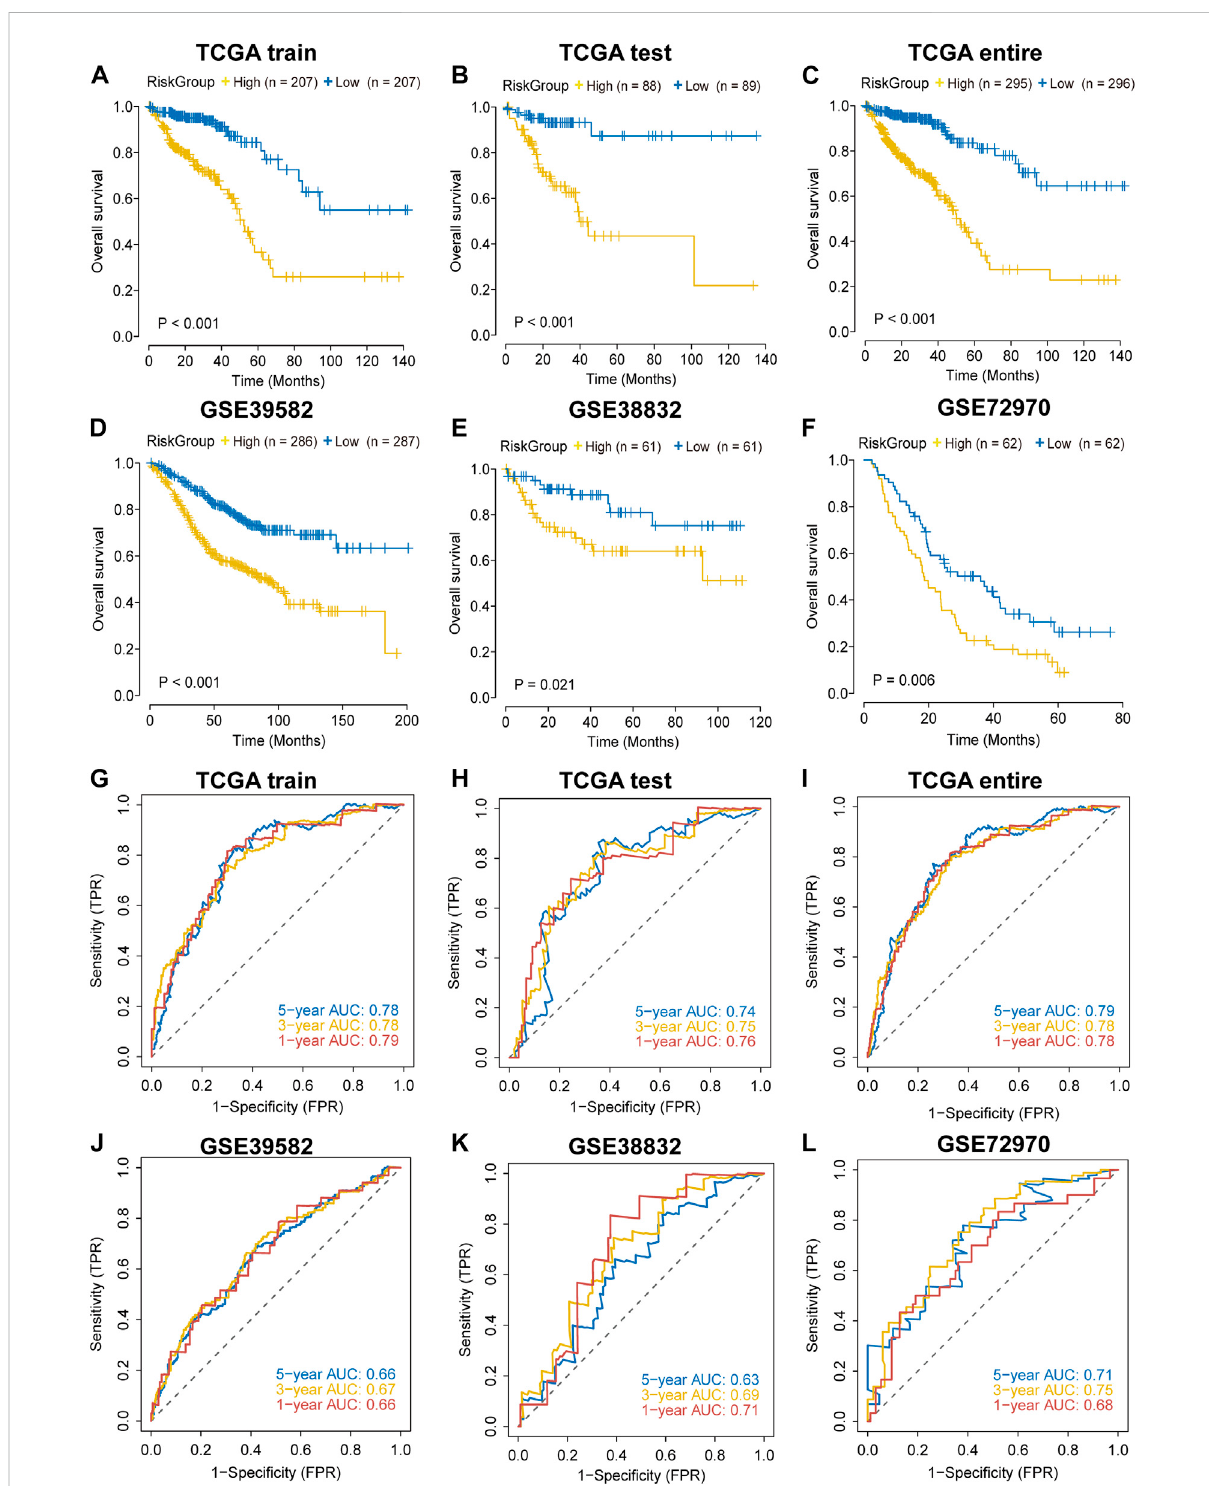
FIGURE 2 Validation of the performance of the IRLncSig for prognostic prediction (A – F) Survival analysis for two groups. The p values were calculated by the Log-rank test. (G – L) ROC curves for predicting 1-, 3- and 5-years